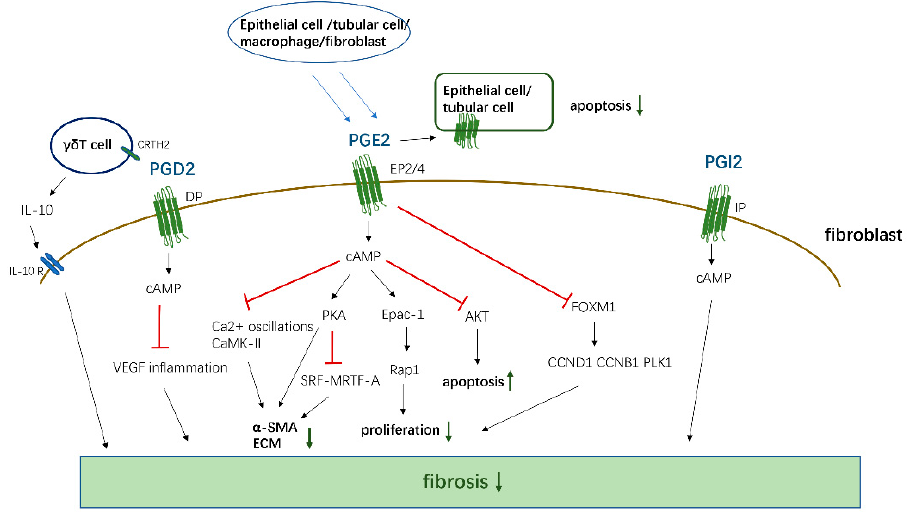
Figure 2. The antifibrotic effects of PGD2, PGE2, and PGI2. PGD2, PGE2, and PGI2 activate cAMP by binding to corresponding receptors, and then inhibit the proliferation, transformation, and ECM generation of fibroblasts, and promote cell apoptosis by affecting downstream signals. At the same time, PGD2 also acts on the CRTH2 receptor on γδ T cell, promoting its release of anti-fibrosis IL-10 to inhibit fibrosis. PGE2 can act on EP2/4 receptors in epithelial cells and Tubular Cells in an autocrine way, thereby inhibiting the apoptosis of these functional cells.